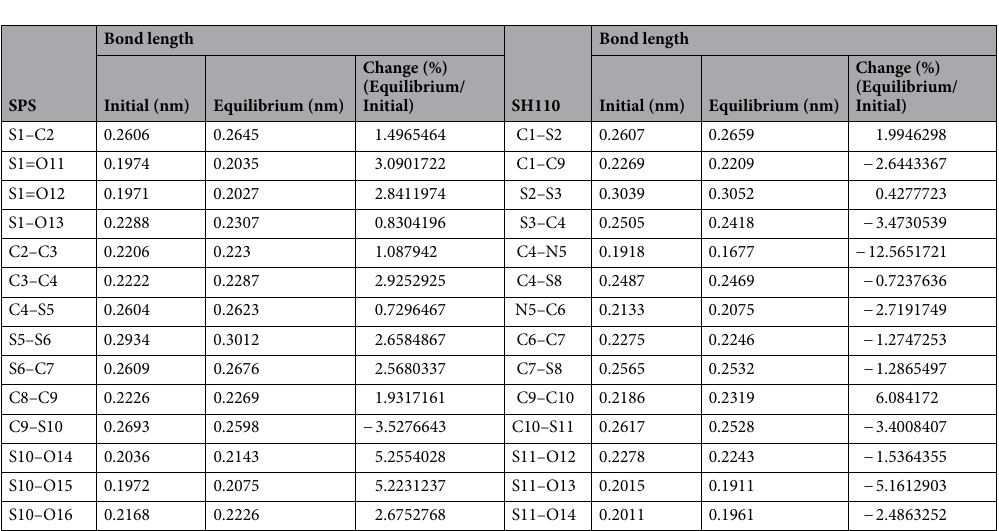
Table 2. Selected bond lengths for SH110 and